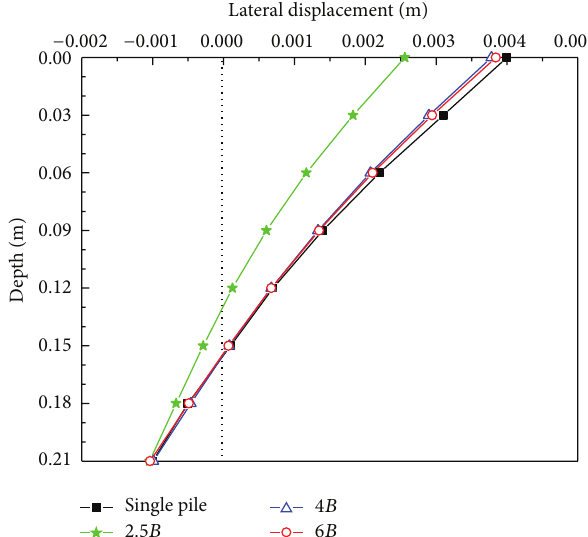
Figure 4: Load versus displacement curves at the active pile cap.